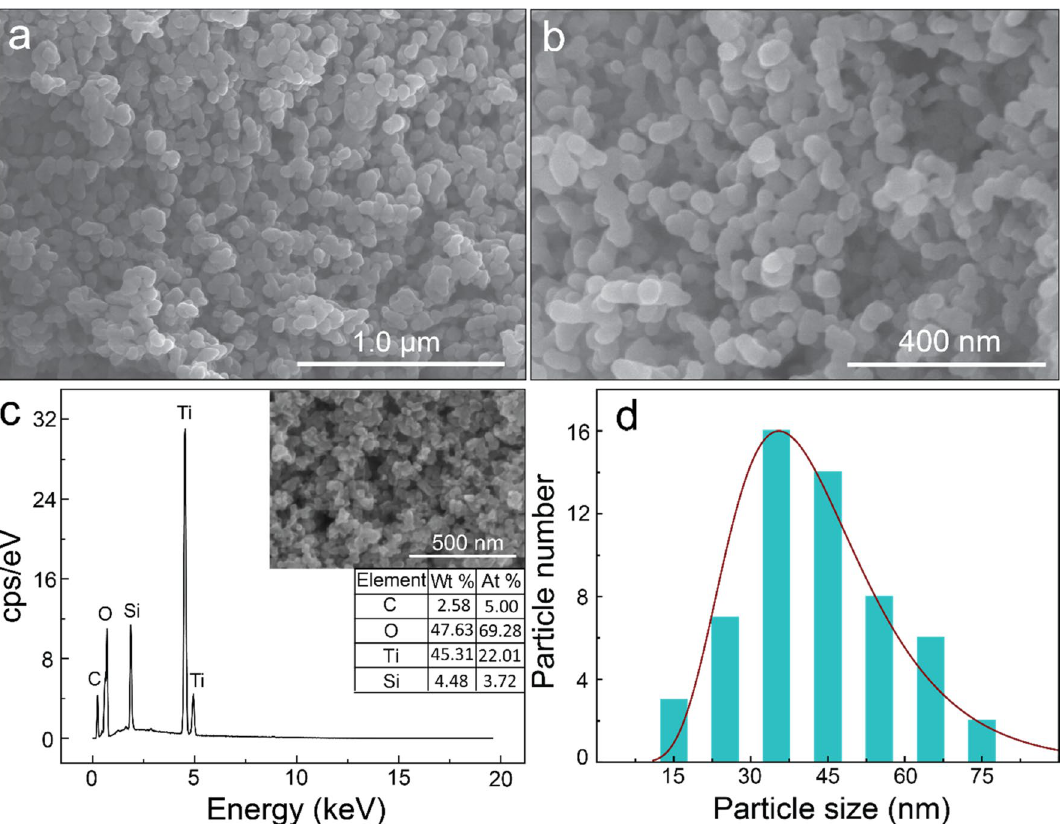
Figure 1. ( a ) Low-resolution and ( b ) high-resolution FE-SEM images, ( c ) EDS curves (the inset shows the corresponding area evaluated by EDS, along with the tabulated data), and ( d ) size distribution of the TTOC-2